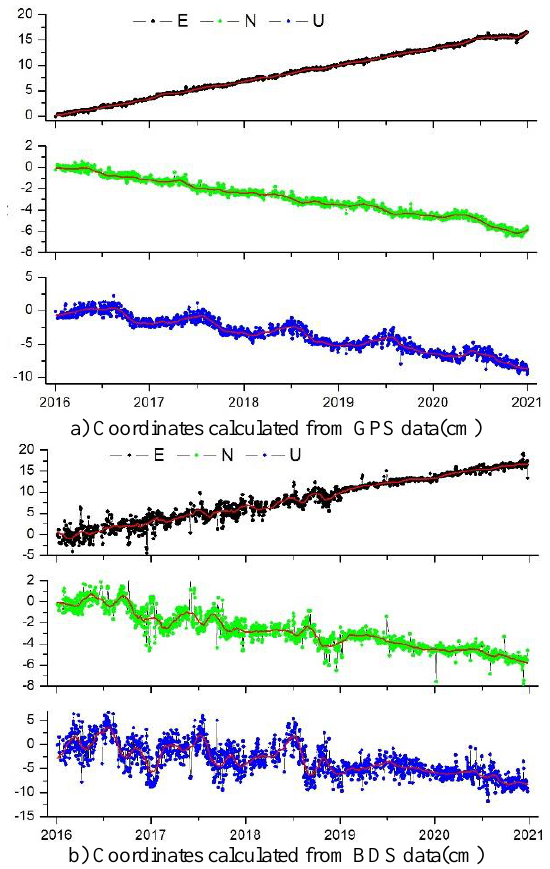
Figure 3 . Comparison of Linear Velocity of Time Series Residual of Station Coordinates